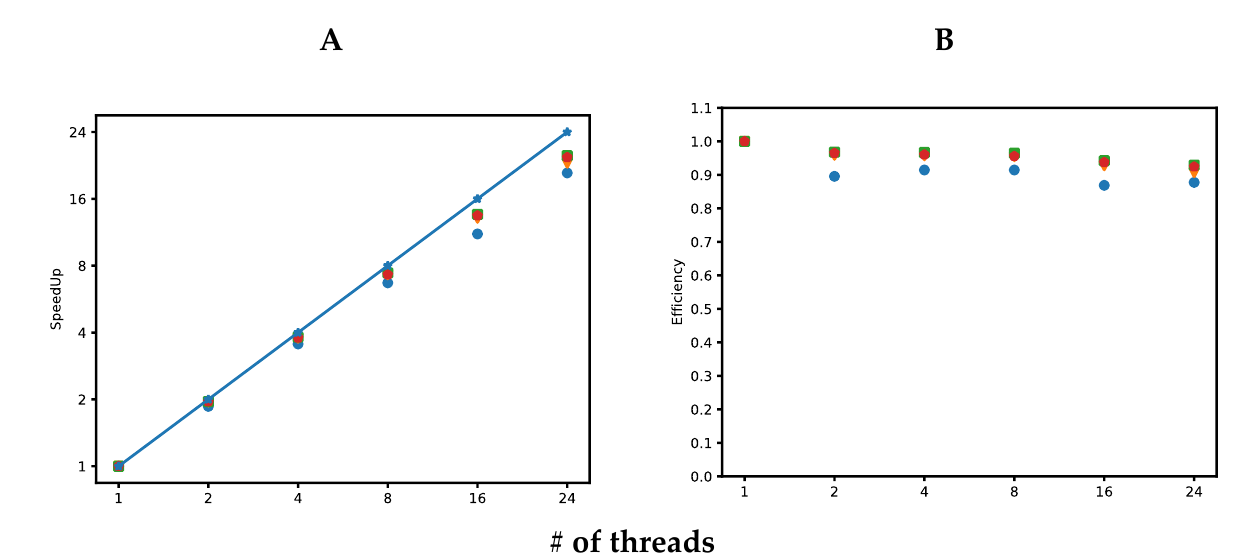
Figure 2. Speedups ( A ) and efficiencies ( B ) of four different implementations of the proposed algorithm. Blue circles correspond to the in-house SVM with Intel compiler. Orange triangles correspond to in-house SVM with Intel G++ compiler. Green squares represent LibSVM with Intel compiler. Red pentagons represent LibSVM with G++ compiler. The straight blue line in A represents a linear (1:1) speedup. # in the X axis, indicate the number of threads used in our computations.